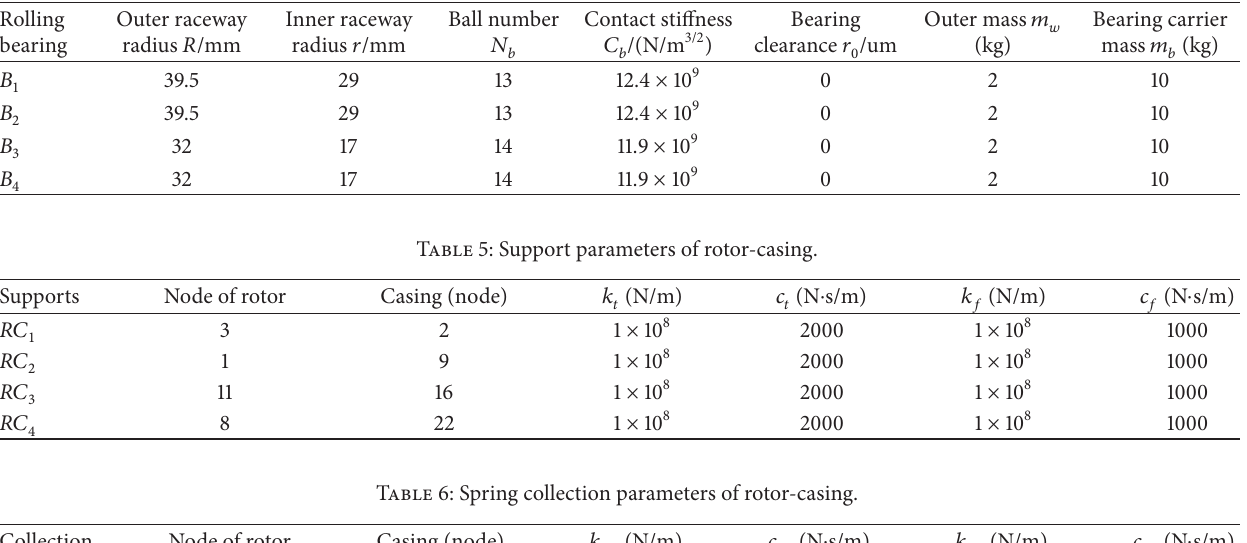
Table 4: Parameters of ball bearing.